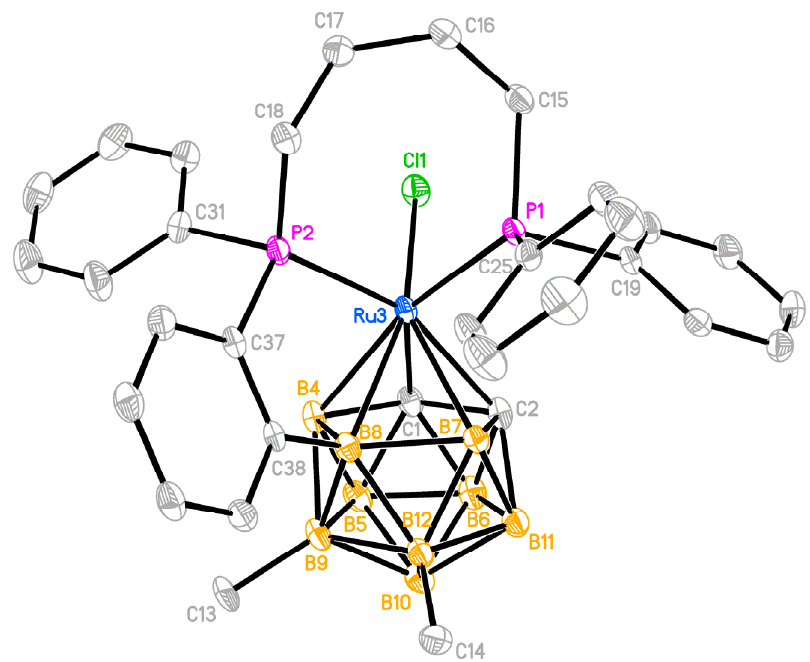
Figure 4. Molecular structure of ruthenacarborane 7 (thermal ellipsoids drawn at the 50% probability level). Hydrogen atoms have been omitted for clarity.